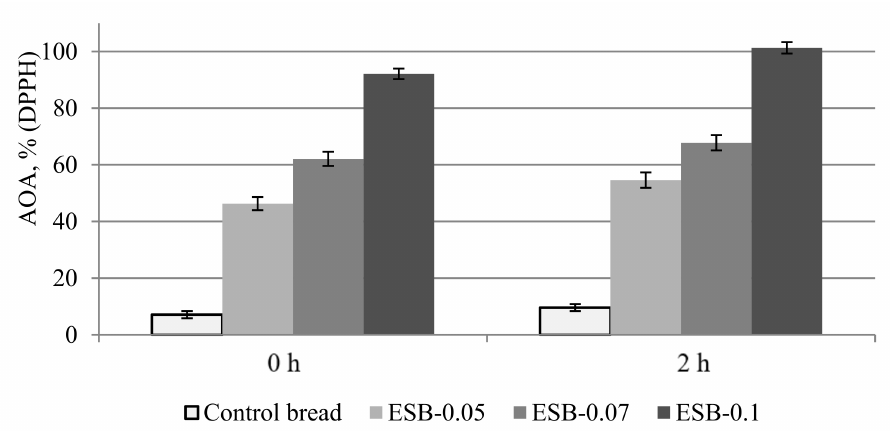
Figure 5. Antioxidant activity of the test samples. Each value is presented as mean ± standard deviation ( n = 3).